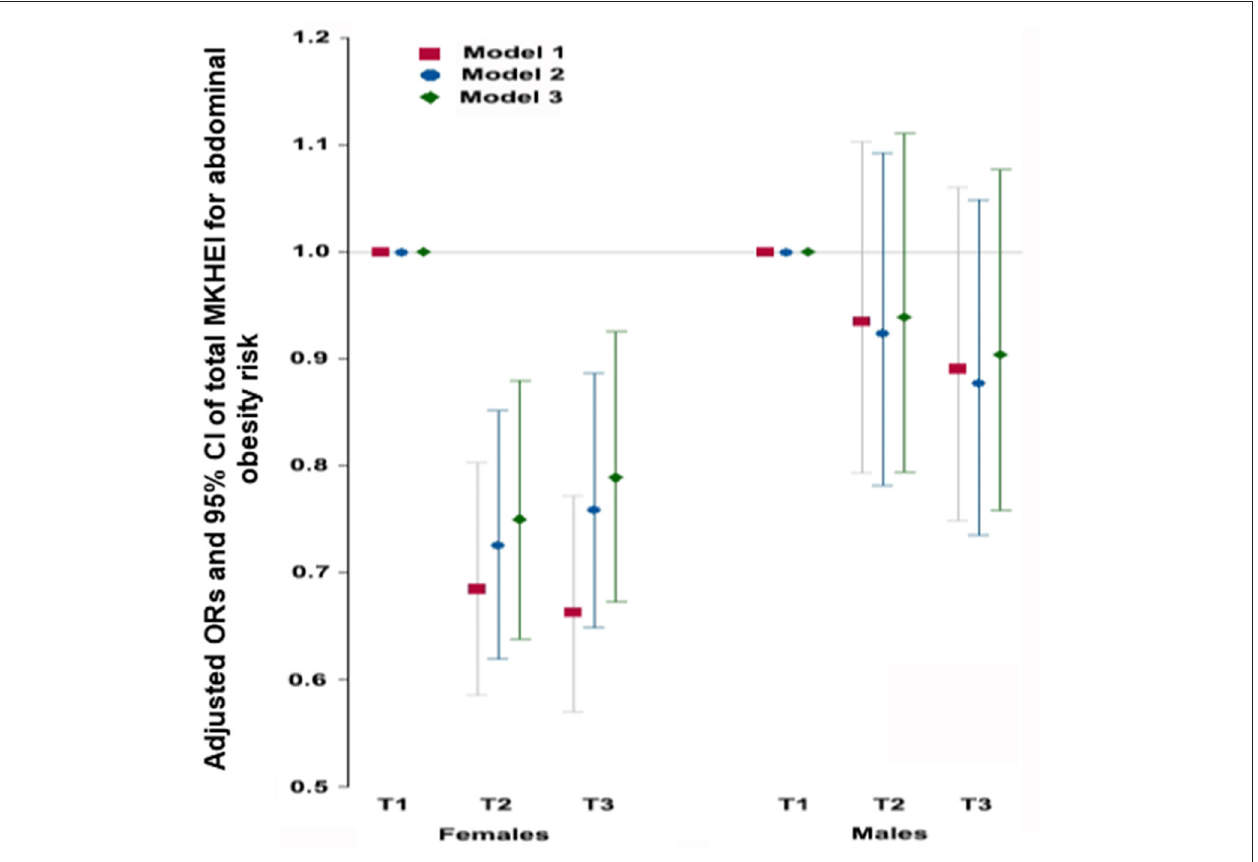
FIGURE 1 | Adjusted odds ratios (95% CI) for abdominal obesity calculated by waist circumference after adjustments for covariates according to modified Korea Health Eating Index (KHEI). Model 1; adjusted for age and residence region. Model 2; adjusted for the covariates of model 1 + education, income, and marital status. Model 3: adjusted for the covariates of model 2 + smoking, alcohol, regular